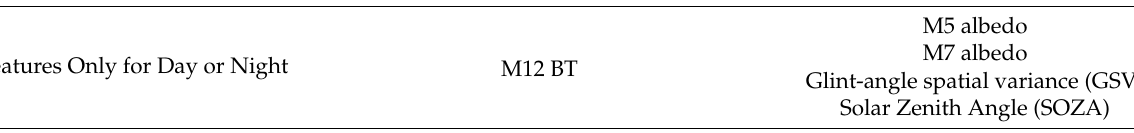
Table 1. Summary of input features and output clear-sky mask (CSM) types in the fully connected deep neural network CSM (FCDN_CSM) v2. Common Input